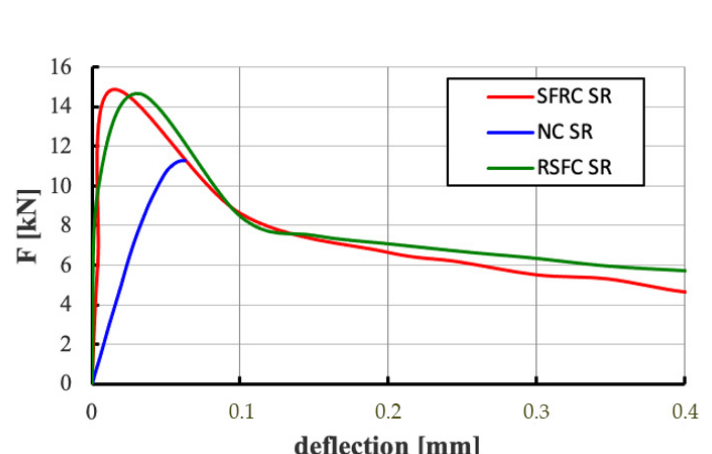
Figure 16. Comparison of diagrams of F-deflection relationships for non-fibre (NC) and fibre (SFRC and RSFRC) concretes obtained during the residual strength test with deflection up to 0.4 mm (3-point test).